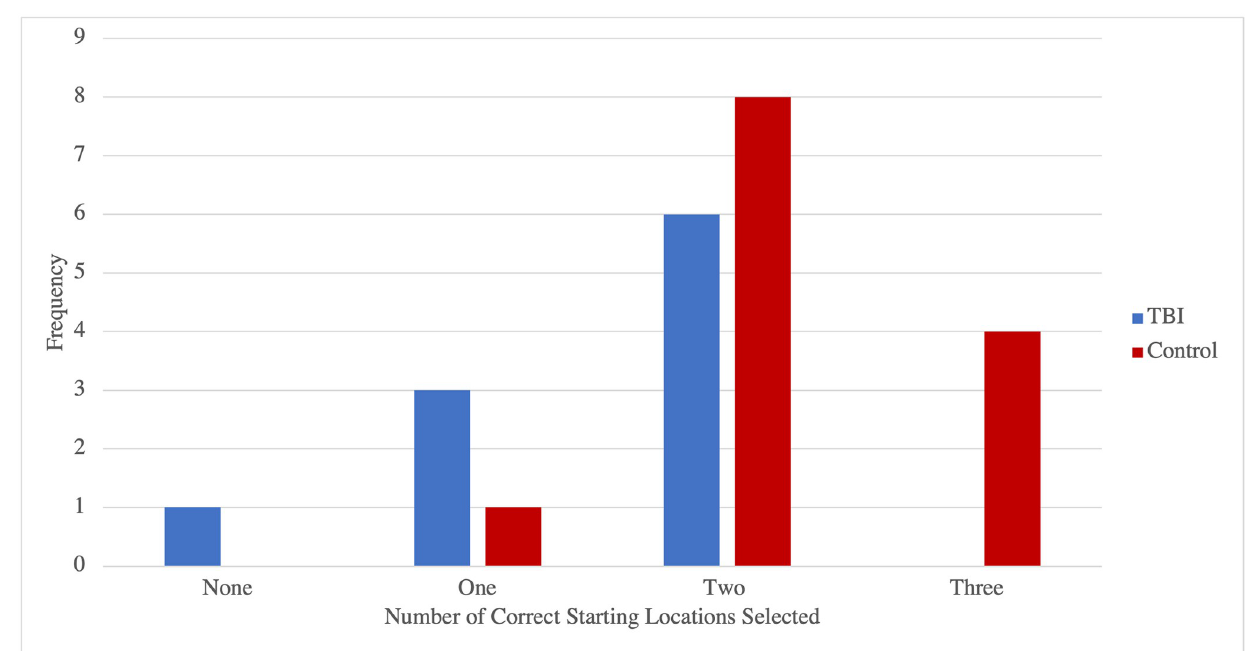
Fig 6. Frequencies of TBI and control participants as a function of overall flare accuracy on path integration levels.